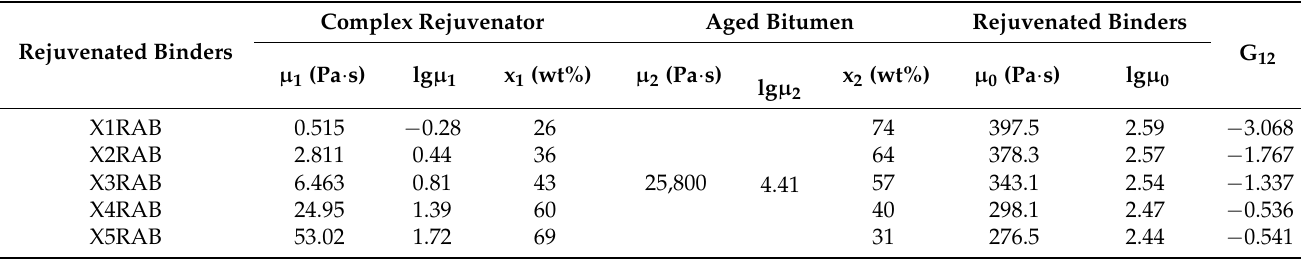
Table 10. G 12 parameter of rejuvenated binders with RX-based rejuvenators.